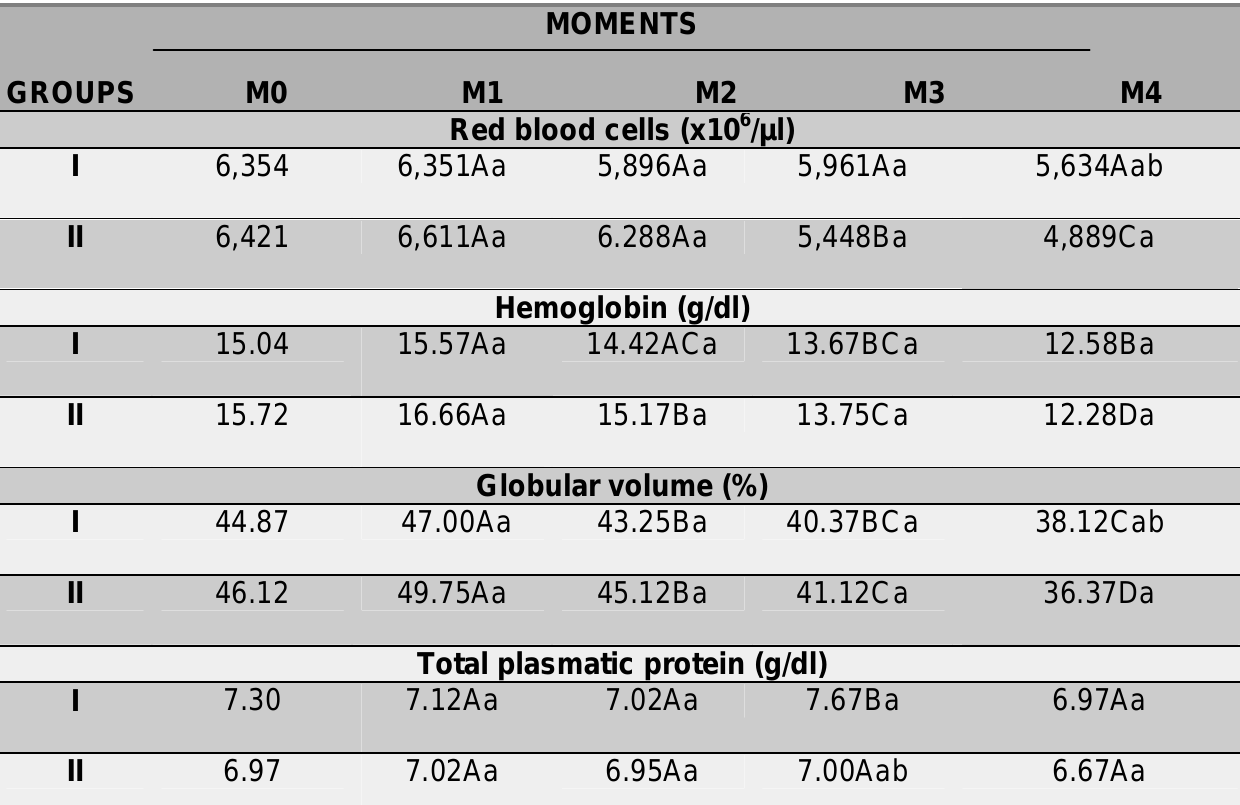
Table 2: Means of red blood cell count according to groups and moments.